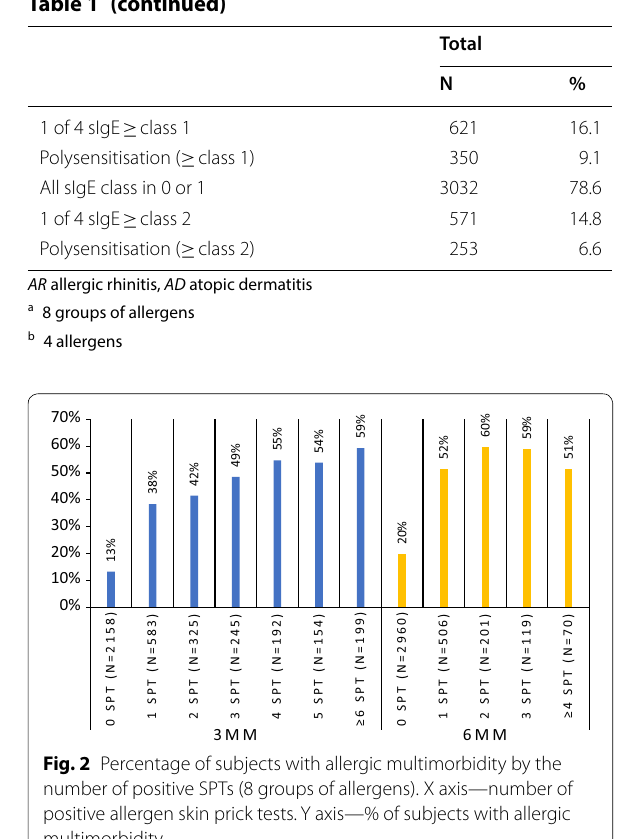
(Additional file 1: Fig. 2).